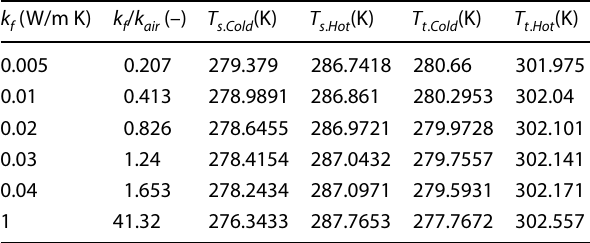
Table 4 Effect of thermal conductivity on outlet